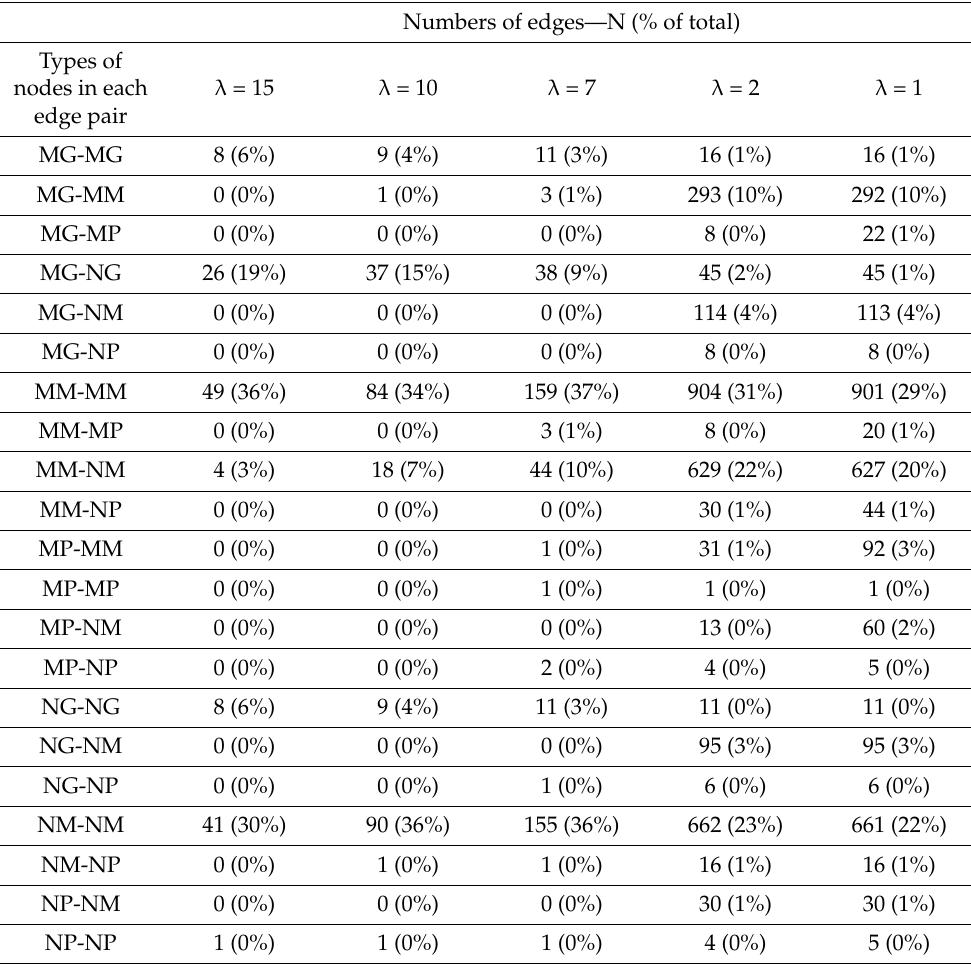
Table 1. Numbers of edges among types of nodes in estimated Bayesian Network Models (BNMs) for a range of λ